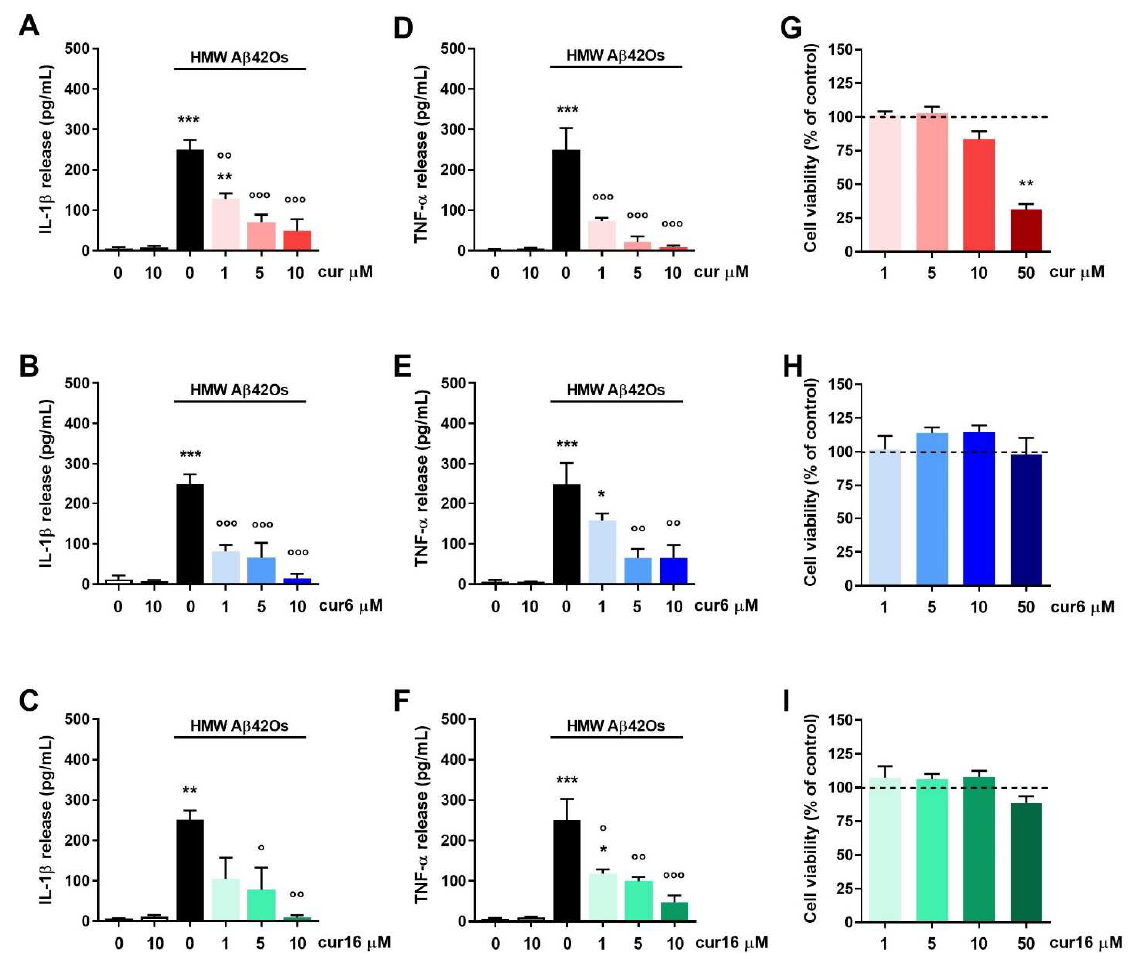
Figure 4. Effect of curcumin and its analogues on cytokine release from HMW A β 42O-stimulated microglia and cell viability. Microglia were cultured overnight in medium containing 10% serum, which was replaced with serum-free medium before pretreatment with curcumin (cur), cur6 , or cur16 (1–10 µ M) followed by stimulation with HMW A β 42Os (1:20 dilution) for 24 h. Supernatants were collected and analyzed for IL-1 β ( A – C ) and TNF- α ( D – F ) release by ELISA. ( G – I ) Cell viability was also determined by MTT assay. Results are expressed as percentage of cell viability relative to control cells (dashed lines). Data are means ± SEM (n = 3 in triplicate). * p < 0.05, ** p < 0.01, and *** p < 0.001 versus control cells; ◦ p < 0.05, ◦◦ p < 0.01, and ◦◦◦ p < 0.001 versus HMW A β